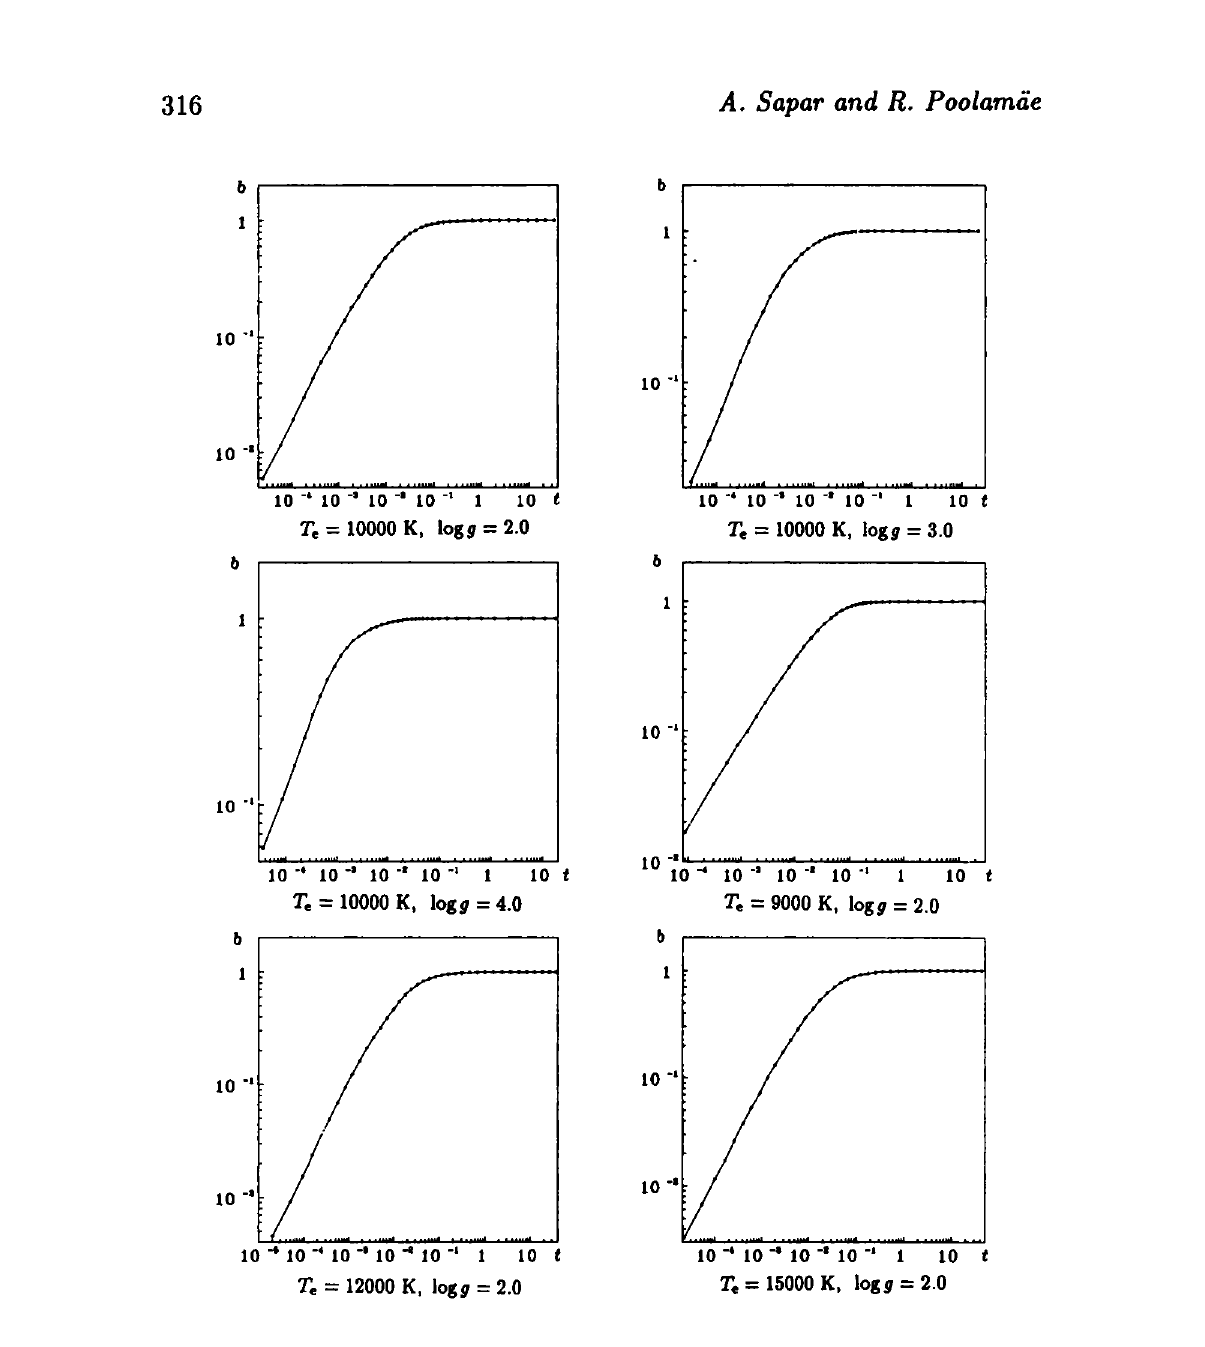
Fig. la. The run of the coefficient of deviation b from LTE for the resonance spectral line CII λ = 1334.515 A for different model atmospheres with effective temperature Τ and gravity g. The argument is logarithm of optical depth t in the continuous spectrum at the spectral line